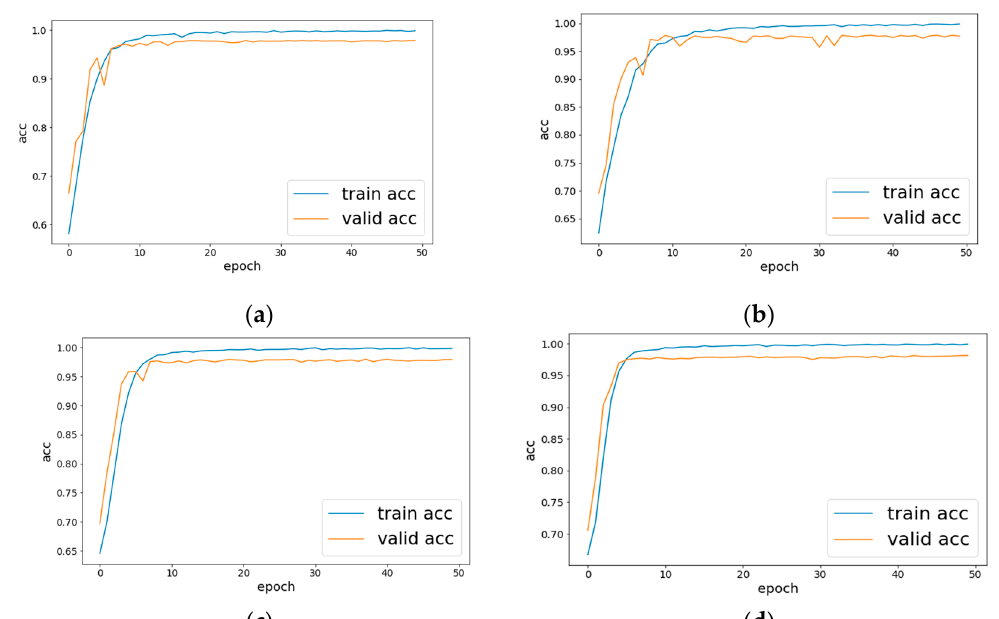
Figure 8. Multi-Head Self Attention structure .